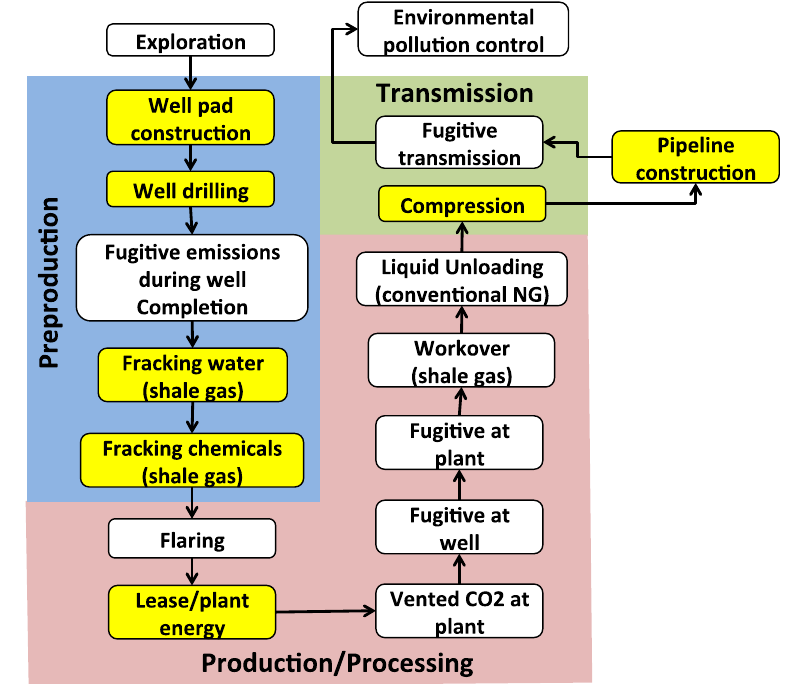
Figure 1. System boundary of gas production processes and energy inputs (indicated by yellow boxes) in EROI